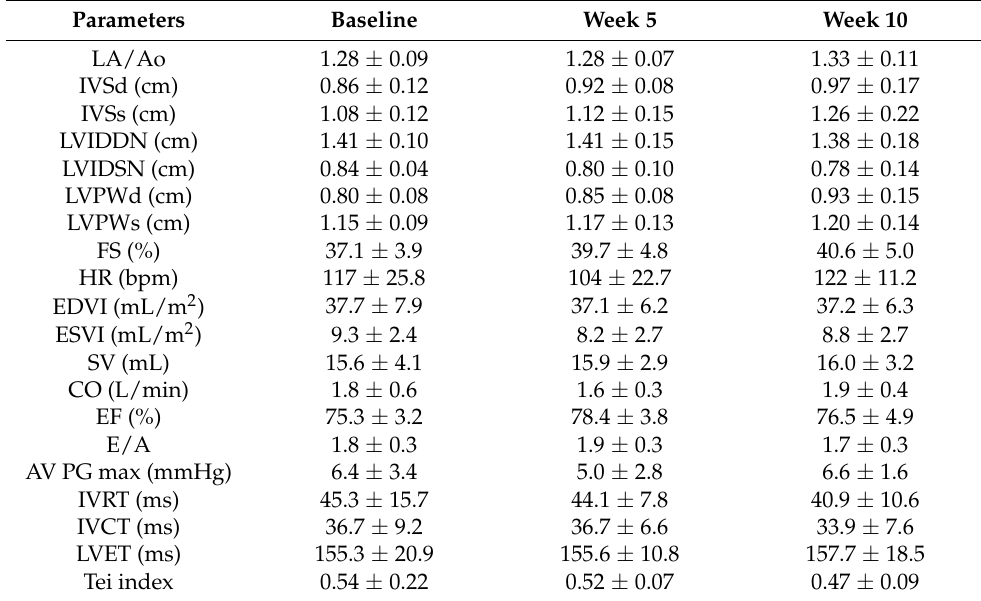
Table 3. Echocardiographic parameters from seven dogs at baseline, week 5, and week 10.